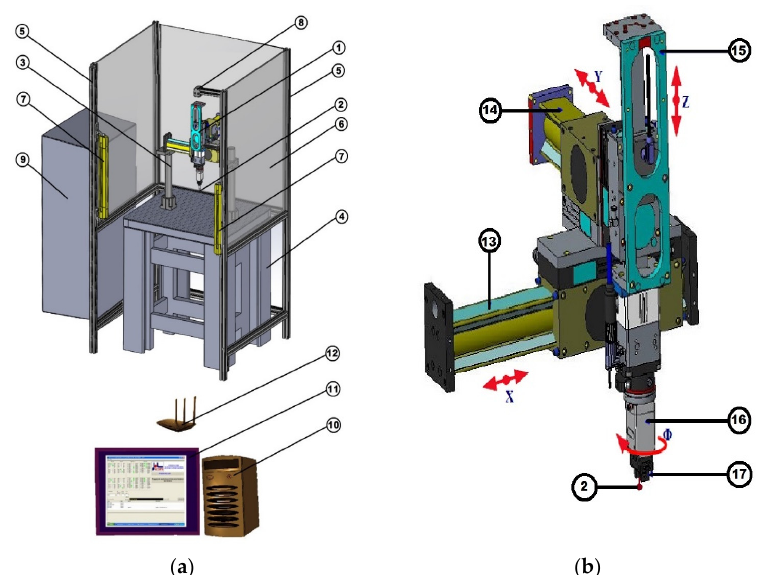
Figure 4. Conceptual CAD model of MMI4D (in SolidWorks): ( a ) MMI4D construction; ( b ) 4D linear and rotating electrical assembly—4D mechatronic system. Legend: 1—mechatronic system in 4D; 2—highly precise 3D Probe; 3—adjustable positioning system; 4—anti-vibration table system; 5—frame for protection; 6—protective walls made of transparent plastic; 7—sensory barriers; 8—IP camera; 9—command and control panel; 10—PC central unit; 11—PC monitor; 12—router; 13—linear electric system X; 14—linear electric system Y; 15—linear electric system Z; 16—electrical rotation system R; 17—electric parallel gripper system.